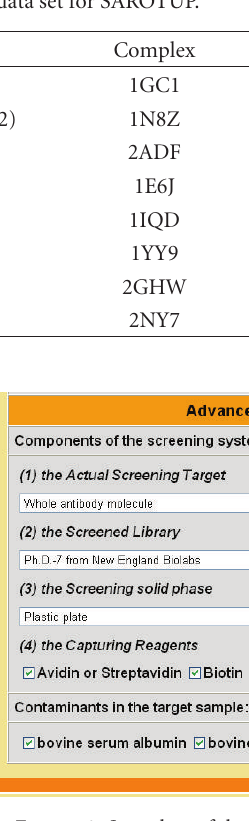
Figure 1: Snapshot of the upper section of SAROTUP. Figure 2: Snapshot of the lower section of